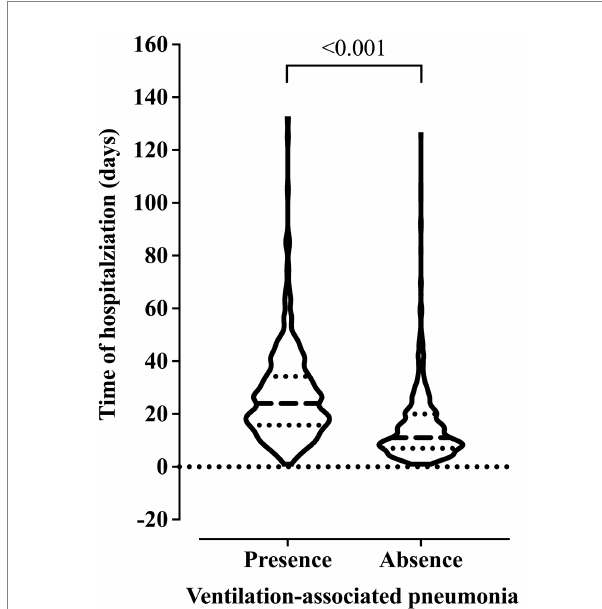
FIGURE 3 Association between the risk of developing ventilation-associated pneumonia according to the length of invasive mechanical ventilation. We carried out the statistical analysis using the Mann– Whitney test and a 0.05 alpha error.